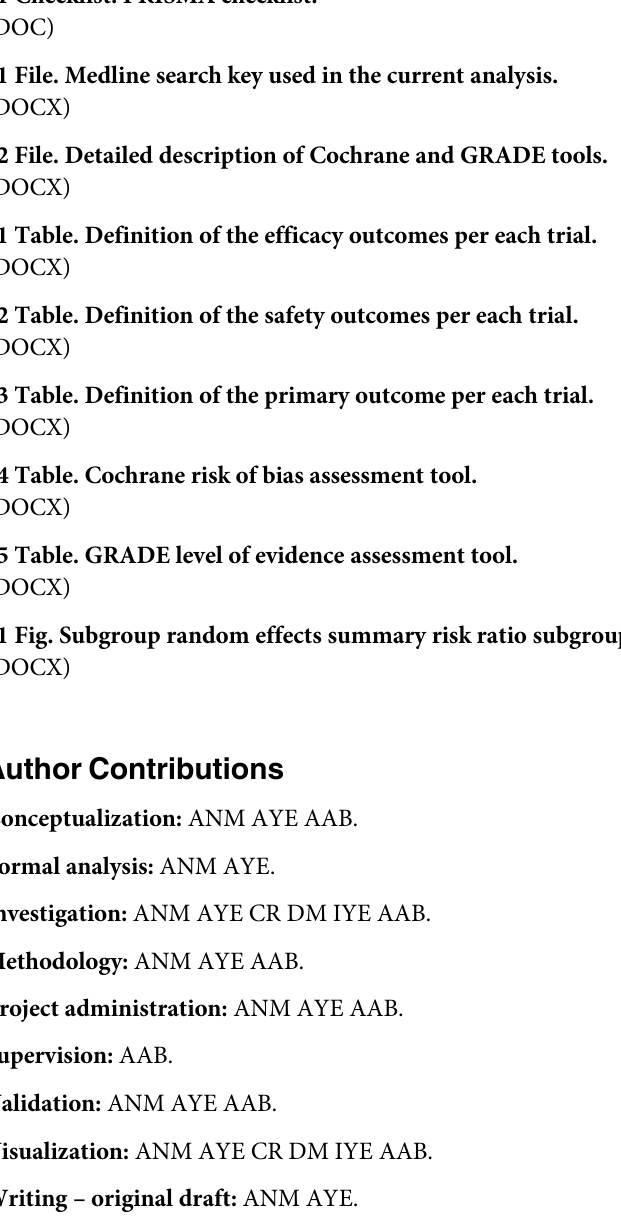
S1 Table. Definition of the efficacy outcomes per each trial. S2 Table. Definition of the safety outcomes per each trial. S3 Table. Definition of the primary outcome per each trial. S4 Table. Cochrane risk of bias assessment tool. S5 Table. GRADE level of evidence assessment tool. S1 Fig. Subgroup random effects summary risk ratio subgroup according to